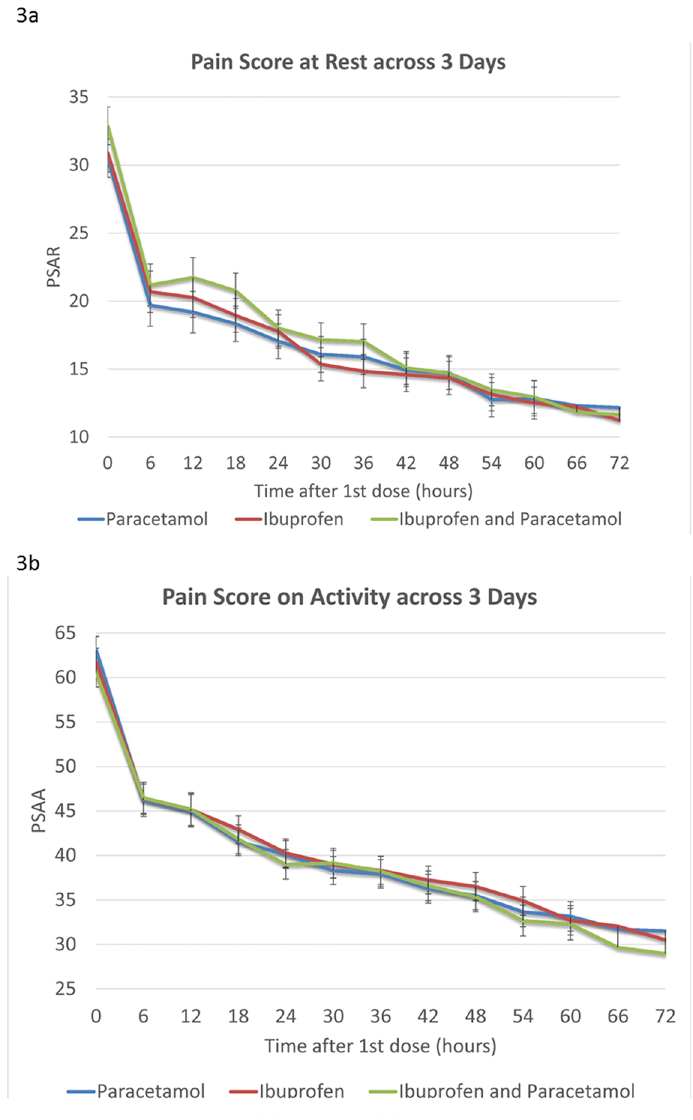
Fig 3. Reduction in VAS score (a) at rest and (b) on activity for the three treatment arms within 3 days.